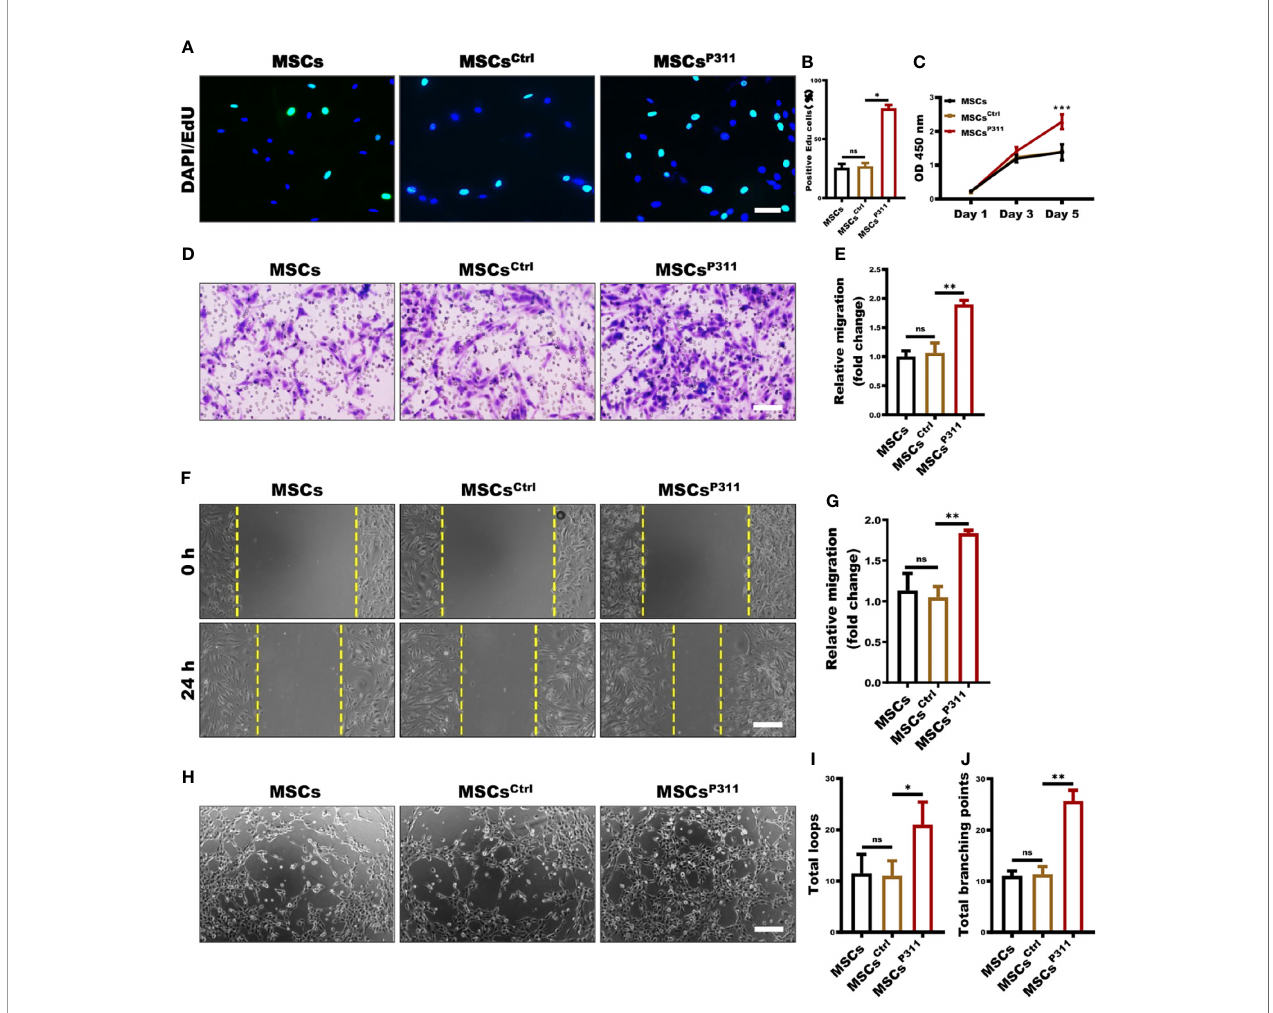
FIGURE 3 | P311 enhances the capability of MSCs-mediated tube-like structure formation. (A – C) The effect of MSCs, MSCs Ctrl , MSCs P311 on the proliferation of ECs was evaluated by using transwell co-culture system (0.4 µm pore size). 4×10 4 ECs seeded on the lower chamber were co-cultured with 1×10 4 MSCs, MSCs Ctrl , MSCs P311 seeded on the upper chamber. (A, B) The proliferation of ECs was examined at single cell levels by EdU assays at 24 hours after co-incubation. Scale bar: 100 µm. (C) Cell viability of ECs was detected by CCK8 assays on 1, 3 and 5 days after co-incubation. (D – G) The effect of MSCs, MSCs Ctrl , MSCs P311 on migration and invasion abilities of ECs was evaluated by means of scratch and transwell assays. (D, E) The invasion of ECs at 24 hours after co-incubation was examined by transwell assays (8-µm pore size). Scale bar: 200 µm. (F, G) The migration of ECs at 24 hours after co-incubation was detected by scratch assays with transwell co-culture system (0.4-µm pore size). Scale bar: 200 µm. (H – J) The effect of MSCs, MSCs Ctrl and MSCs P311 on tube-like structure formation of ECs was evaluated by Matrigel assays with transwell co-culture system (0.4-µm pore size). ECs on 24-well plates supplement with Matrigel were co-cultured with MSCs, MSCs Ctrl or MSCs P311 on transwell insert with 0.4-µm pore size. The formation of tube-like structure was photographed under optical microscope. Representative images for the formation of tube-like structure and statistical analysis were shown. Scale bar: 200 µm. MSCs group: MSCs + ECs; MSCs Ctrl group: MSCs Ctrl + ECs; MSCs P311 : MSCs P311 + ECs. Scale bar: 50 µm. Data are representative of at least three independent experiments and represent mean ± SD. (ns, no statistical signi fi cance; *P < 0.05; **P < 0.01; ***P <